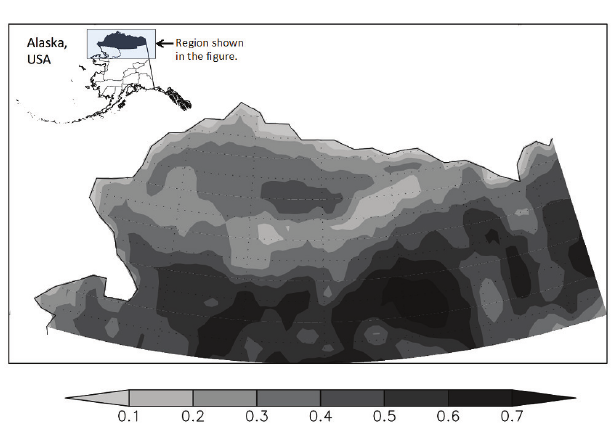
Fig. 1. Average annual MAI for northern Alaska for the period 1979–2009 showing regions of high (dark) and low (light) potential mosquito